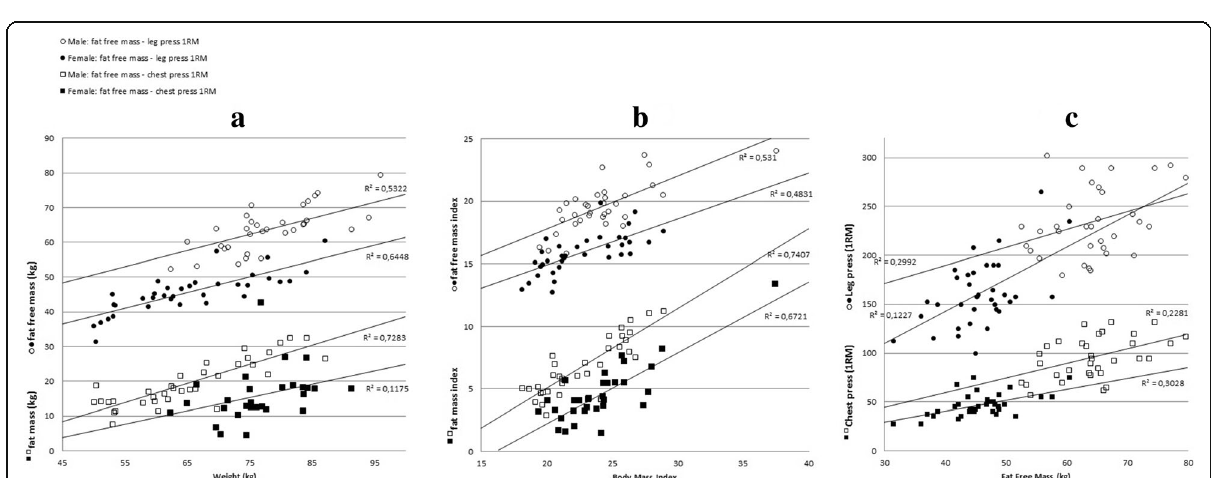
Fig. 2 Correlational analyses. a Correlations between weight and fat mass and between weight and fat-free mass for male and female participants, separately. b Correlations between BMI and fat mass index and between BMI and fat-free mass index for male and female participants, separately. c Correlations between fat-free mass and strength measures for male and female participants, separately